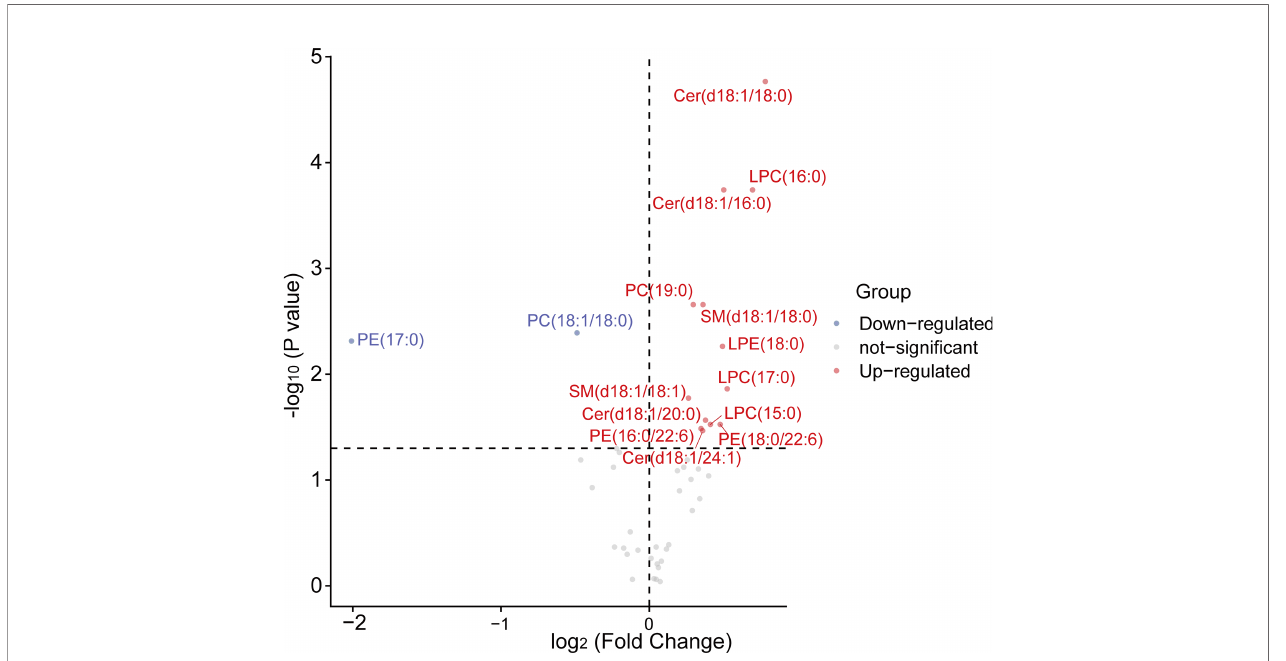
FIGURE 1 | The volcano plots of 45 serum lipids levels between control and T2DM groups. A total of 15 lipids exhibited signi fi cant differential abundance ( P < 0.05) with 2 of them down-regulated and 13 of them up-regulated when comparing T2DM patients to control. Mann-Whitney U tests were used to calculate statistical signi fi cance. Differentially lipid species with different fold changes were individually color-coded with up-regulated lipids in red, down-regulated in blue, and not- signi fi cant in grey. LPC, lysophosphatidylcholine; PE, phosphatidylethanolamine; LPE, lysophosphatidylethanolamine; PC, phosphatidylcholine; SM, sphingomyelin; Cer,